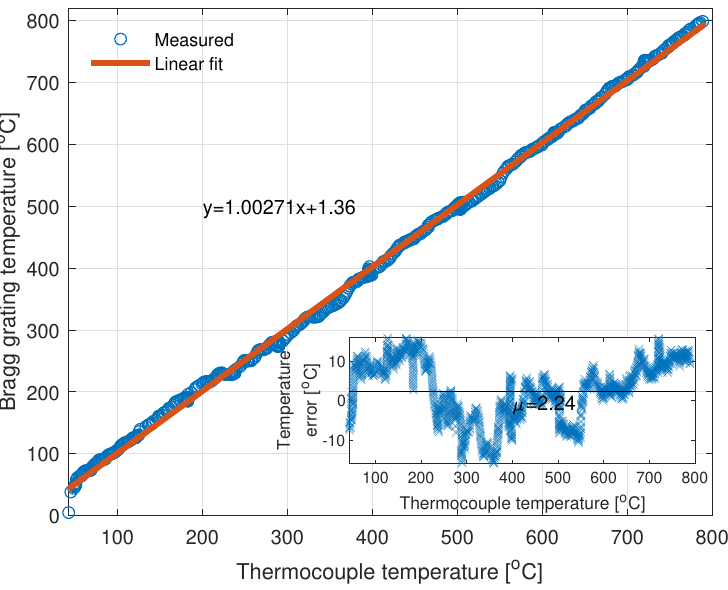
Figure 13. Temperature calculated with the FBG-based sensors versus temperature obtained from the thermocouple. The linear regression parameter R 2 =